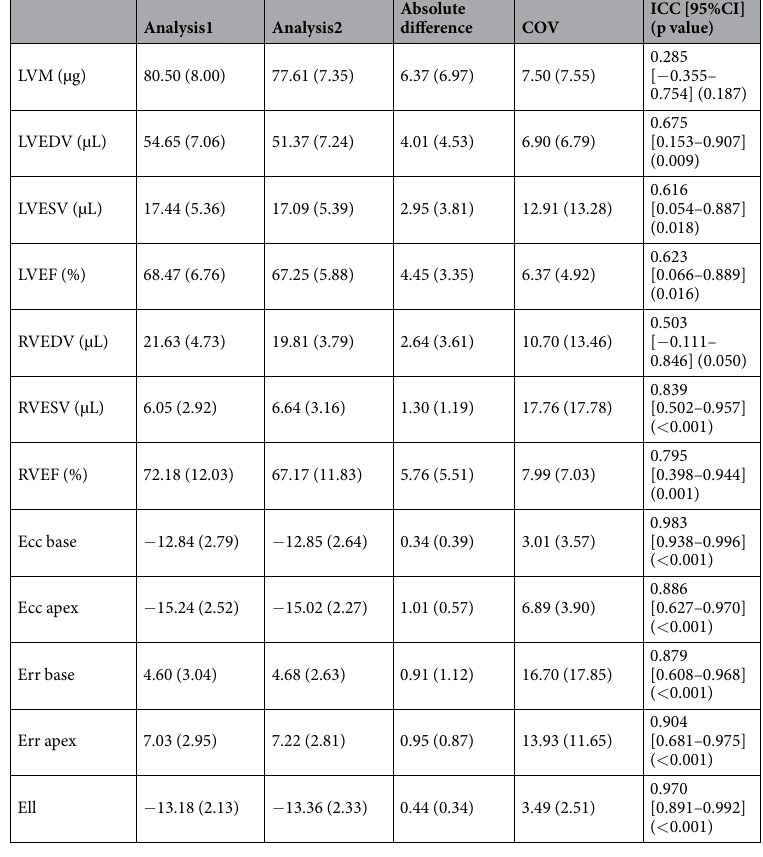
Table 5. Intra-observer reproducibility as evaluated by the absolute difference, coefficient of variation (COV) (expressed in %) and interclass correlation (ICC) between results from the first (analysis1) and second (analysis2) post-processing of data from the same CMR examinations by the same observer. Data are the mean (SD) except for ICC [95% interval confidence] (p